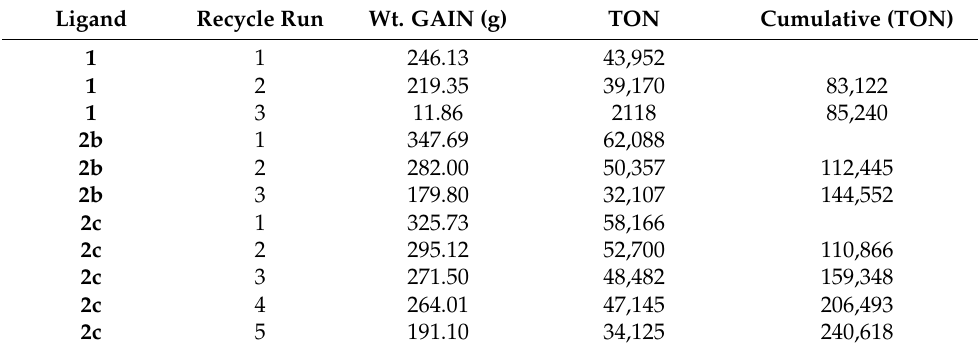
Table 4. Comparison of the Alpha ligand, 1 , and bulky adamantyl ferrocene ligands— 2b, and 2c —in the palladium-catalysed formation of methyl